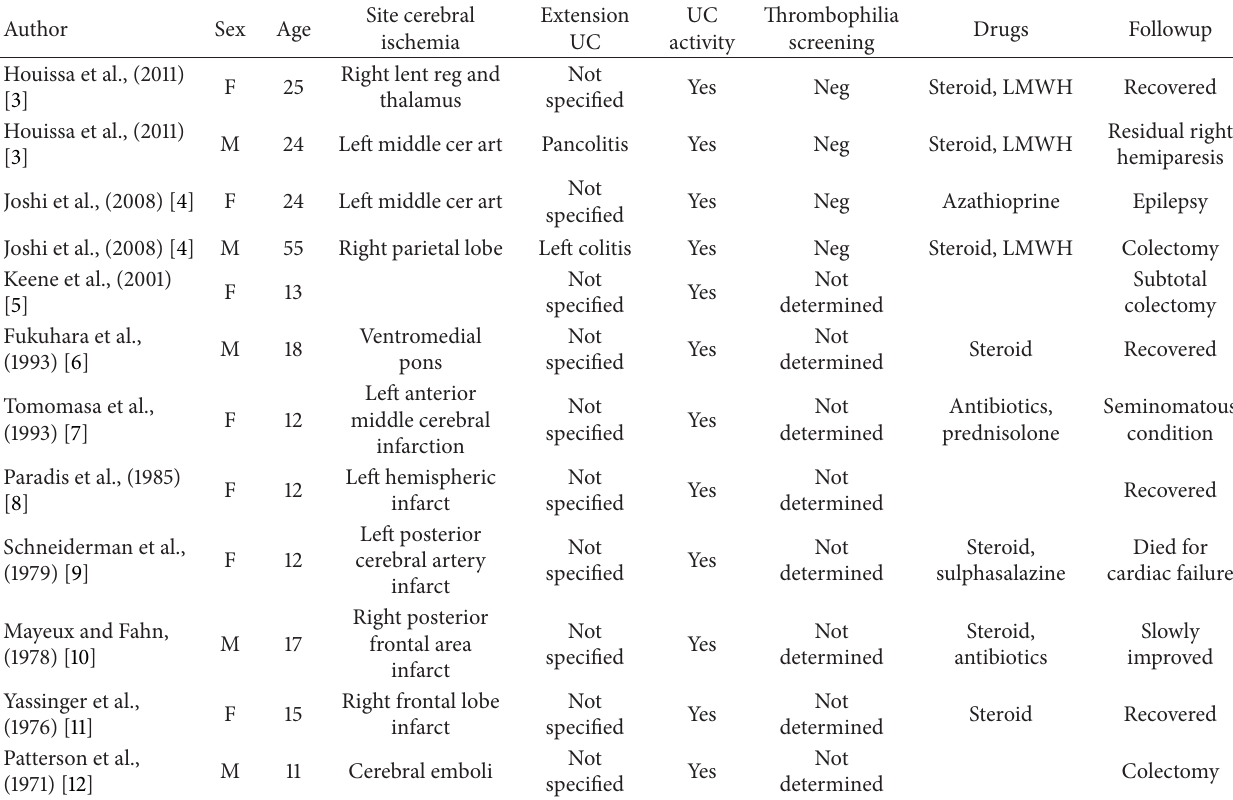
Table 1: “Cerebral Arterial Thrombosis in Ulcerative Colitis”: table of cases reported in international